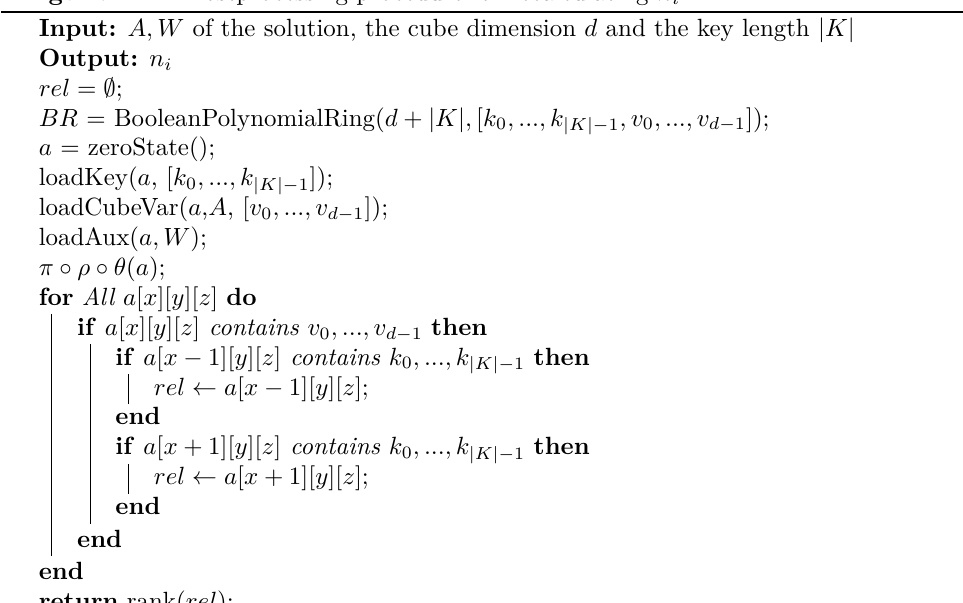
Algorithm 1: Postprocessing procedure for recalculating n i